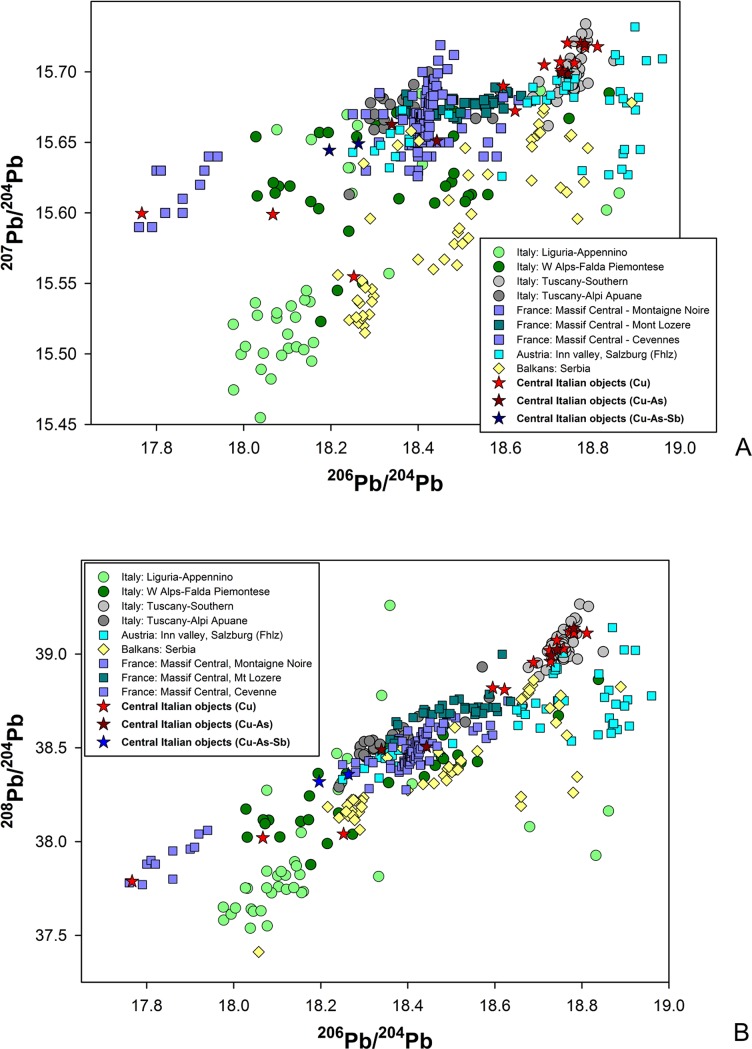
LI signatures of central Italian metal objects; (a): 2D plot of 206Pb/204Pb vs 207Pb/204Pb LI data; (b) 2D plot of 206Pb/204Pb vs 208Pb/204Pb LI data.